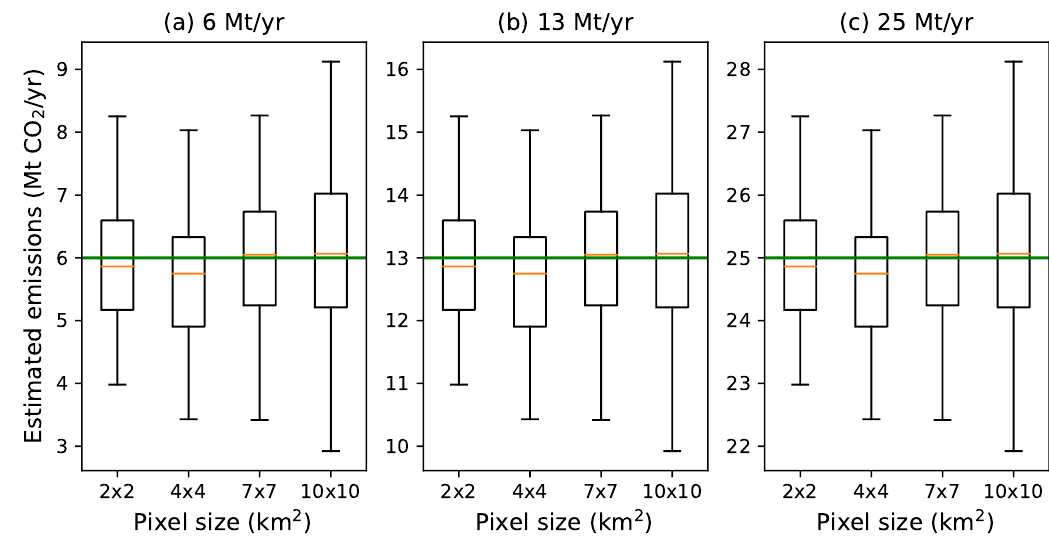
Figure 5. Emission rate estimates for all 12 combinations of pixel sizes and emission rates for an ensemble of 30 simulations. The green line is the true simulated emission rate, the orange line in each box is the median emission estimate, the black boxes show the range between the lower and upper quartiles (the interquartile range, IQR), and the whiskers (capped black lines) extend from the smallest datum within 1.5 times the IQR below the box to the largest datum within 1.5 times the IQR above the box. Outliers outside this range are shown as open circles. ( a ) Emission rate estimates for a 6 Mt yr − 1 source. ( b ) Emission rate estimates for a 12 Mt yr − 1 source. ( c ) Emission rate estimates for a 25 Mt yr − 1